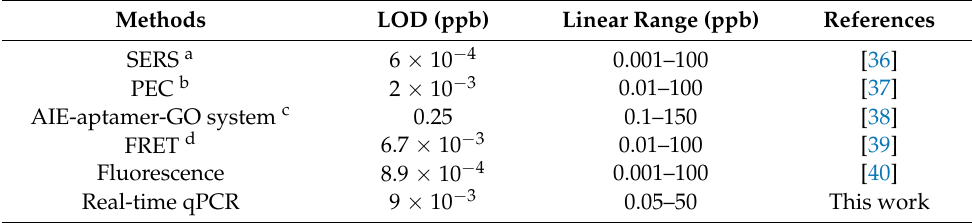
Table 3. Comparison of the developed AFB1 aptasensors.